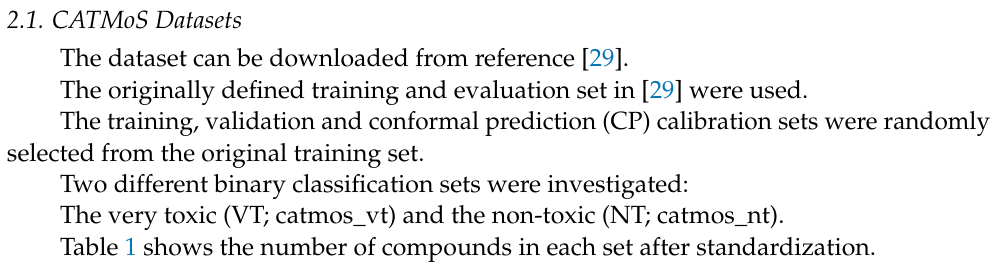
Table 1. Number of compounds in each of the sets.